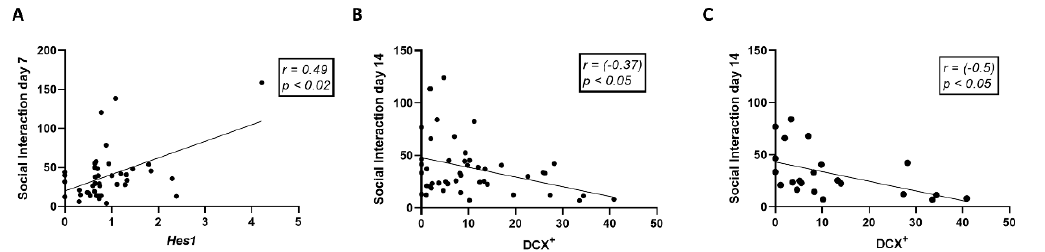
Figure 8. Social behavior correlates with hippocampal neurogenesis. Linear regression graphs depicting the correlation between Hes1 gene expression and social interaction duration at day 7 ( A ). Correlation between the number of DCX + cells in the dentate gyrus and social interaction duration at day 14 for all experimental groups ( B ) and trauma-exposed groups only ( C ). Correlations were calculated using Pearson test.